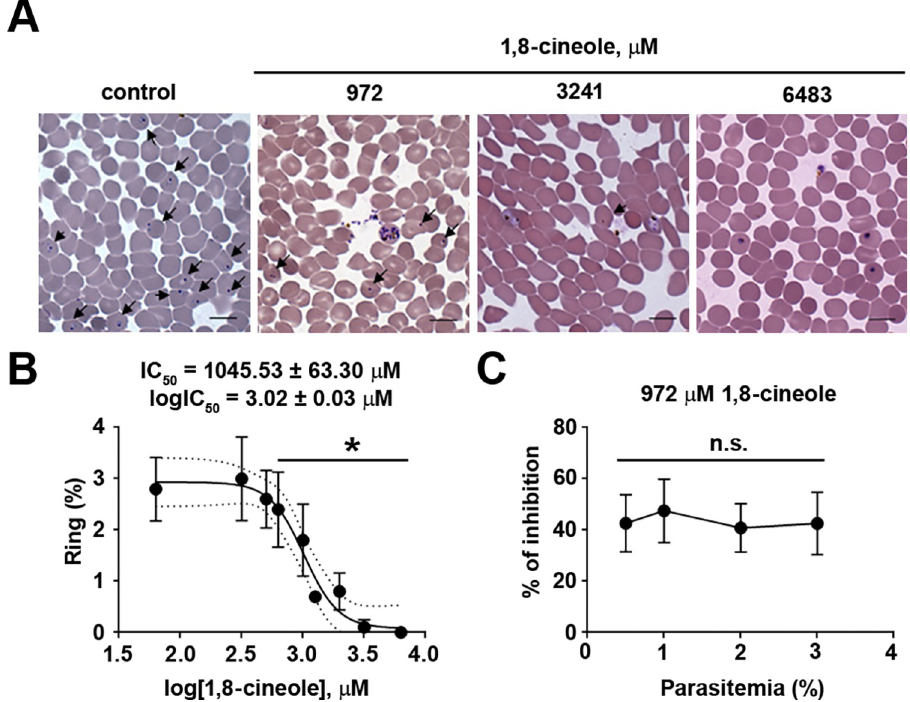
Fig 1. The monoterpene 1,8-cineole decreased parasitemia levels in vitro. Synchronized cultures of erythrocytes infected with mature forms of P . falciparum were incubated with 1,8-cineole for 24 h to monitor parasitemia. (A and B) Dose-response effect of 1,8-cineole on parasitemia ( n = 4). (A) Representative images of the different experimental conditions. Arrows indicate infected erythrocytes with ring form. (B) Infected erythrocytes (1% parasitemia, 3%–5% hematocrit) were incubated for 24 h with increasing concentrations of 1,8-cineole (65–6483 μ M). After incubation, the percentage of ring forms was determined by optical microscopy as described in the Materials and methods section. (C) The inhibitory effect of 1,8-cineole was not dependent on the level of parasitemia ( n = 5). The number of rings was monitored after treating erythrocytes infected with increasing amounts of schizonts (0.5%–3% parasitemia) with 972 μ M 1,8-cineole for 24 h. The results are presented as the mean ± SD. � P < 0.05 versus control. n.s., not significant.